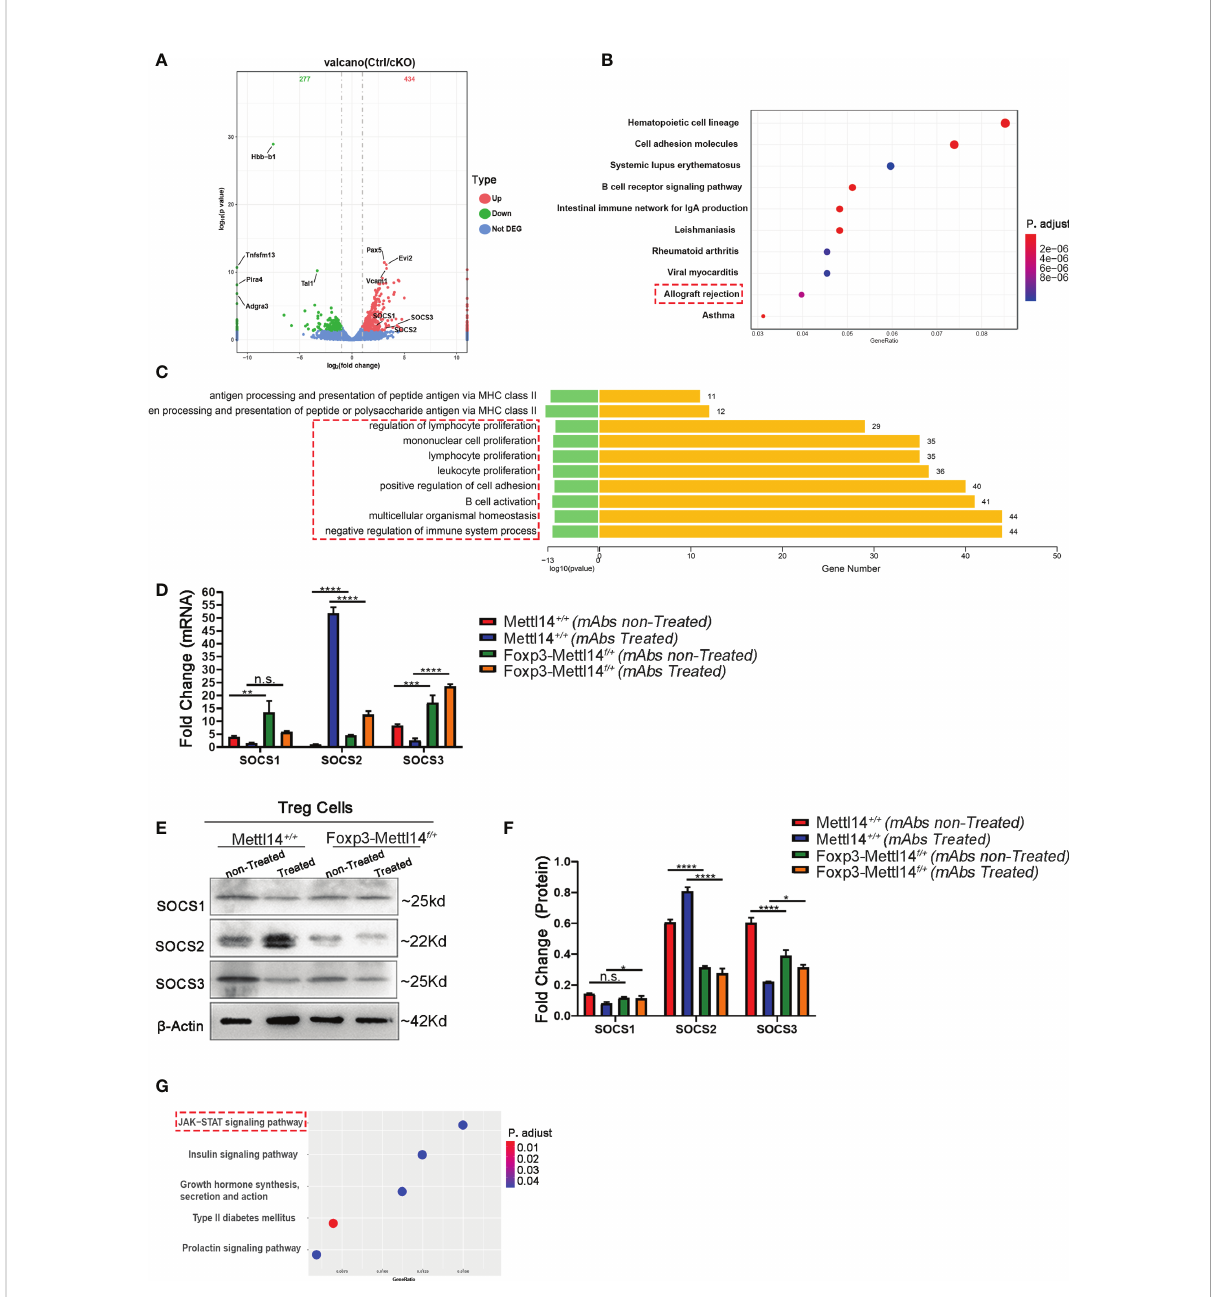
FIGURE 6 The SOCS family was disturbed in Foxp3-Mettl14 f/+ cKO mice. (A) RNA-seq indicated that 434 genes were upregulated and 277 genes were downregulated in Treg cells from Foxp3-Mettl14 f/+ cKO mice compared with the littermate controls. (B) Gene Ontology (GO) enrichment analysis indicated that transplantation related signaling pathways were altered in Treg cells from Foxp3-Mettl14 f/+ cKO mice. (C) KEGG pathways were enriched in proliferation and activation in immune cells. (D – F) The expression of SOCS1, SOCS2 and SOCS3 in Treg cells from littermate controls and Foxp3-Mettl14 f/+ cKO mice on day 7 post-transplantation in the presence or absence of mAbs was validated using qPCR and western blotting. (G) KEGG pathway enrichment analysis of the RNA-seq results for the Socs2 gene, which indicated that the JAK-STAT signaling pathway was altered in METTL14 de fi cient Treg cells post-transplantation. The data are shown as the means ± SD and are representative of three separate experiments. The data in (D) depict the mean mRNA expression normalized to the gene Gapdh. The data in (F) depict the mean protein expression normalized to the b -Actin.The statistical analysis was performed with an unpaired Student ’ s t-test (two- tailed).****P<0.0001, ***P<0.001, **P<0.01, *P<0.05. P values >0.05 were considered nonsigni fi cant